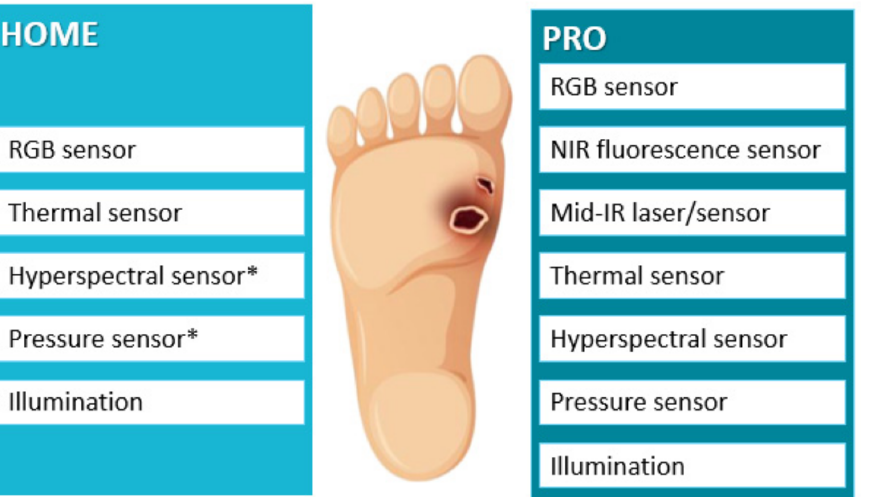
Figure 2. The sensorial components for each of the two supported editions of our photonics-based device. The “*” in the figures refers to sensors that may not be include in the final version of the edition. Its final inclusion depends on the results of the clinical study and the cost of these